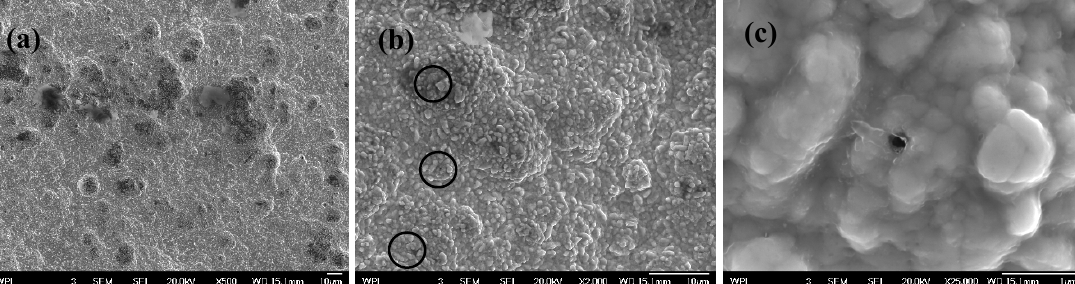
Figure 13. SEM image of the Pd membrane after the permeation tests at various magnifications: ( a ) X500 ( b ) X2000 and ( c ) X25,000